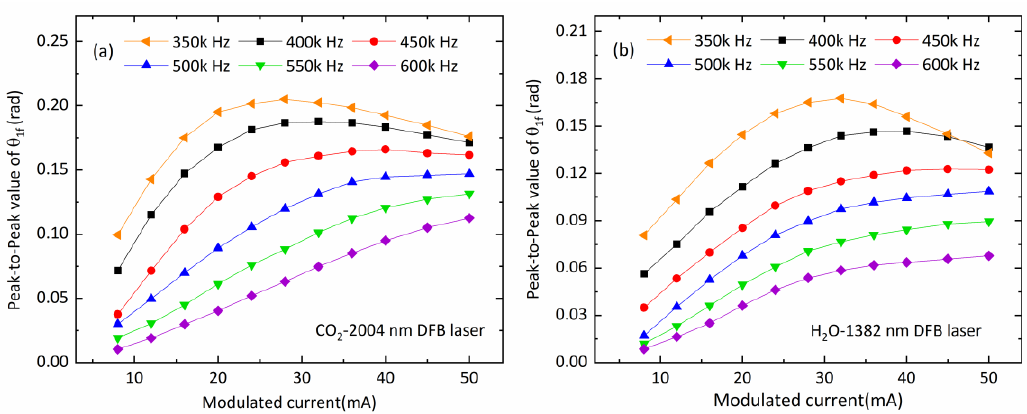
Figure 4. Dependence of the measured peak-to-peak values of θ 1 f phase signal on modulation amplitudes and frequencies applied to diode lasers for ( a ) CO 2 spectral line and ( b ) H 2 O vapor spectral line.